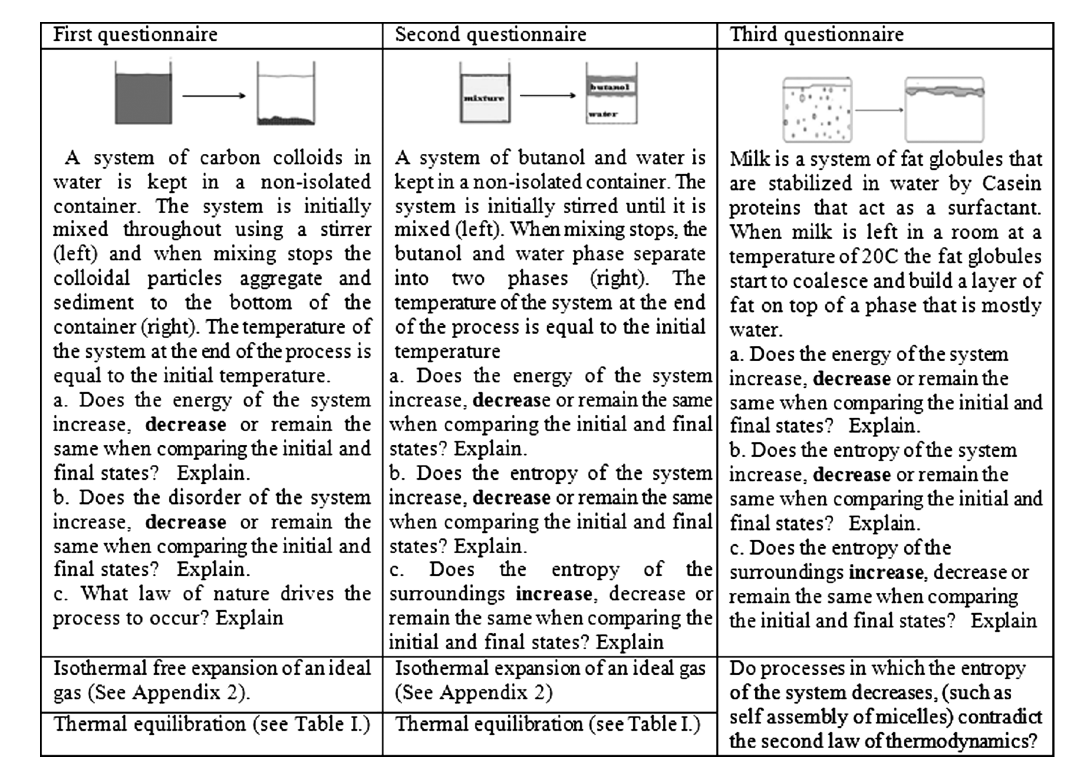
FIG. 1. The format of the three questionnaires. The correct predictions to the phase separation problem are marked in